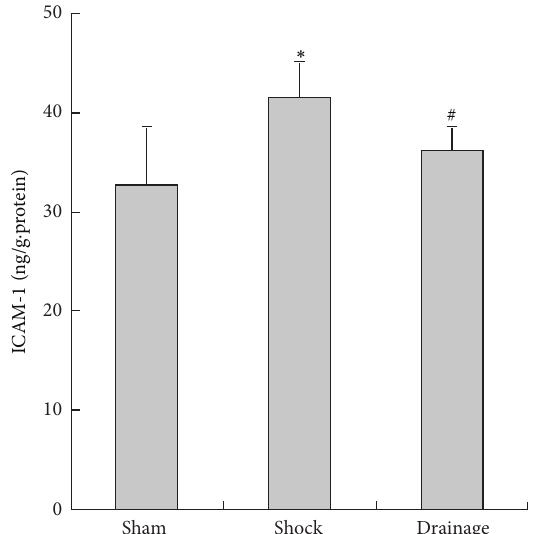
Figure 7: Effects of mesenteric lymph drainage on ICAM-1 contents of renal homogenate in hemorrhagic shock rats without resuscita- tion (ng/g ⋅ protein, mean ± SD, 𝑛 = 6 ). ∗ 𝑃 < 0.05 versus sham group; # 𝑃 < 0.05 versus shock group.